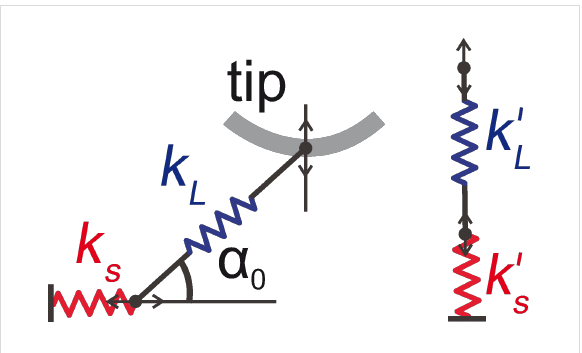
Figure 3: One-dimensional spring model of the manipulation process. Left: The molecule is represented by a spring with stiffness k L , the surface corrugation by a spring with stiffness k S . The molecule is tilted by an angle α 0 with respect to the surface. Right: For simplification, the two springs are replaced by vertical effective springs with constants and . For more details, refer to the main